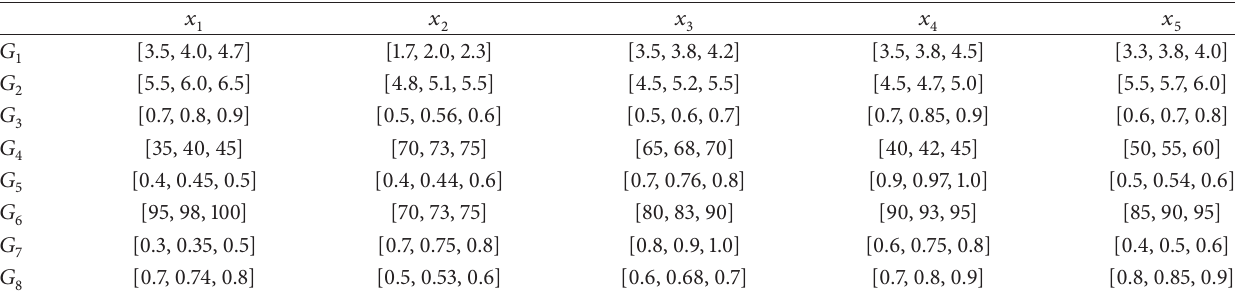
Table 1: Triangular fuzzy number decision matrix 𝐴 (1) .